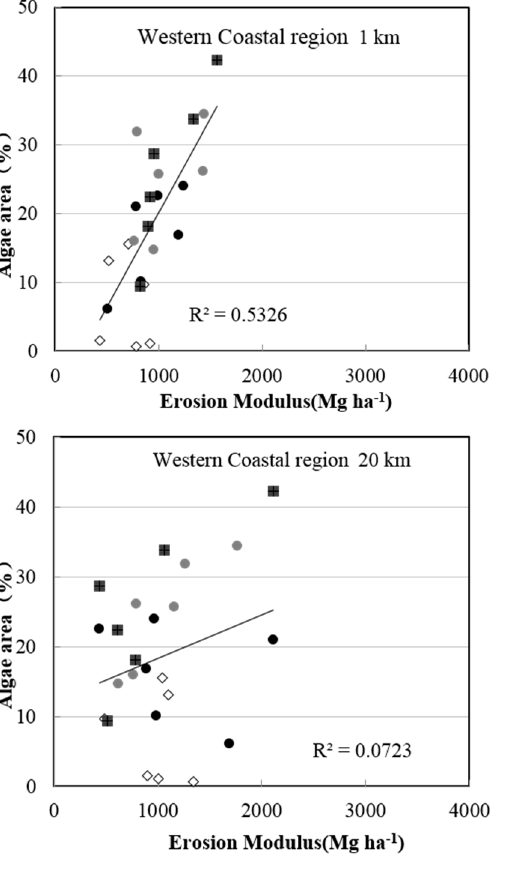
Figure 5. The scatter plots of the erosion modulus and algae areas within different regions for three watersheds.